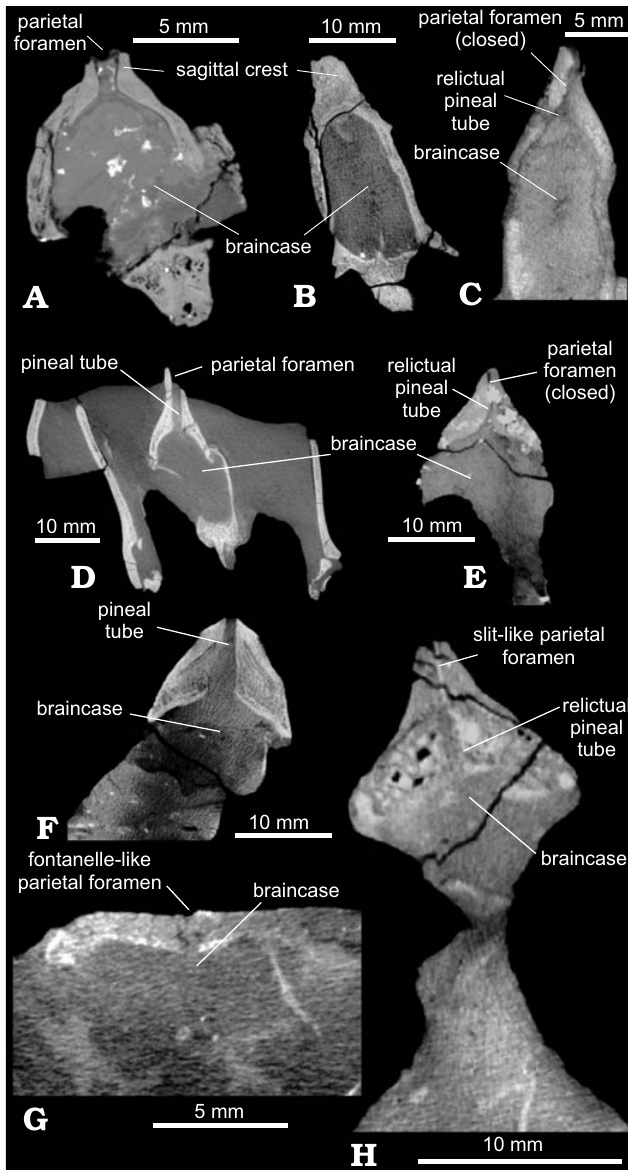
Fig. 5. CT-sections through the sagittal crest in Cynodontia (A–D) and Therocephalia (E–H) illustrating the variability of the parietal foram- ina. A . Cynosaurus suppostus Schmidt, 1927, BPI/1/1563 (voxel